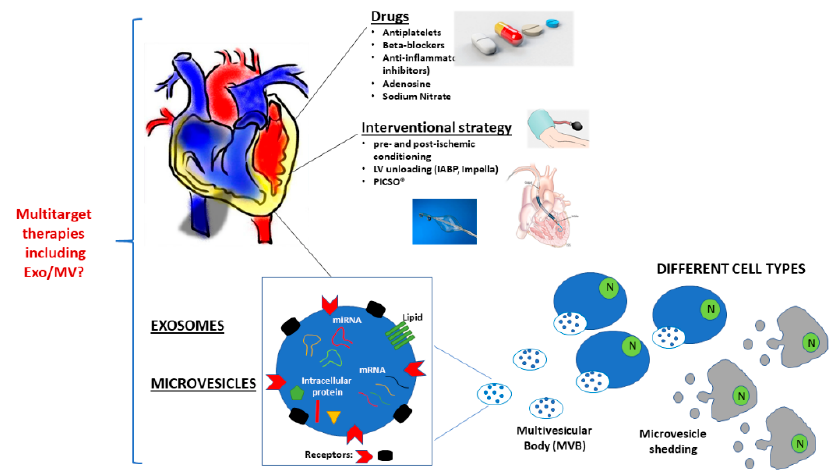
Figure 1. Current and future strategies to reduce ischemia / reperfusion (I / R) damage. Schematic representation of current pharmacological and interventional approaches to avoid long-term complication in MI patients are reported. In addition, a schematic representation of Exosomes (Exo) and Microvesicles (MV) is drawn. The possibility to exploit Exo and MV alone or in combination with pharmacological or interventional therapeutic options will represent the future challenge.